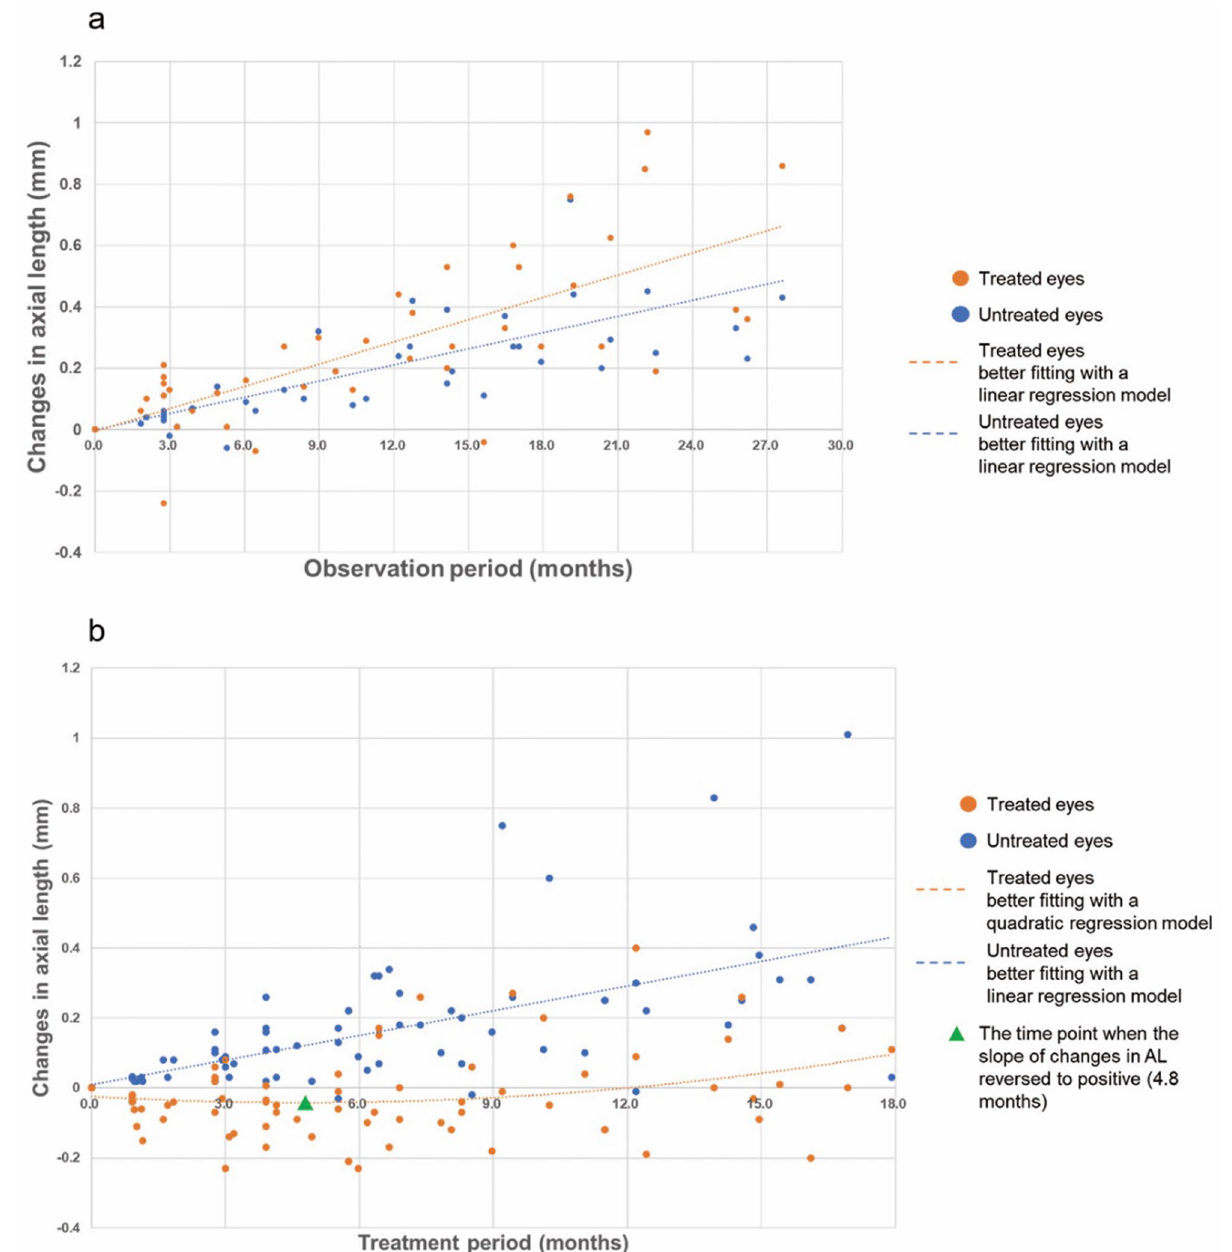
Figure 2. Best-fitting regression models to identify relationships between changes in AL and time in the treated and untreated eyes during the observation ( n = 32) ( a ) and treatment ( n = 40) ( b ) periods. ( a ) Best- fitting models of the changes in AL with time during the observation period in the treated and untreated eyes were both linear and produced high correlations ( R 2 = 0.647 and 0.639, respectively). The linear formulas are y = 0.0242 x – 0.0038 for the treated eyes and y = 0.0176 x – 0.0012 for the untreated eyes. ( b ) Best-fitting models of the changes in AL with time during the treatment period in the treated and untreated eyes were quadratic with a concave function ( R 2 = 0.068) and linear ( R 2 = 0.422), respectively. The green triangle indicates the turning point ( x = 4.8 months) when the slope of the changes in AL became positive in the treated eyes. The quadratic formula is y = 0.0008 x 2 − 0.0076 x − 0.0241 for the treated eyes and the linear formula is y = 0.0236 x + 0.0085 for the untreated